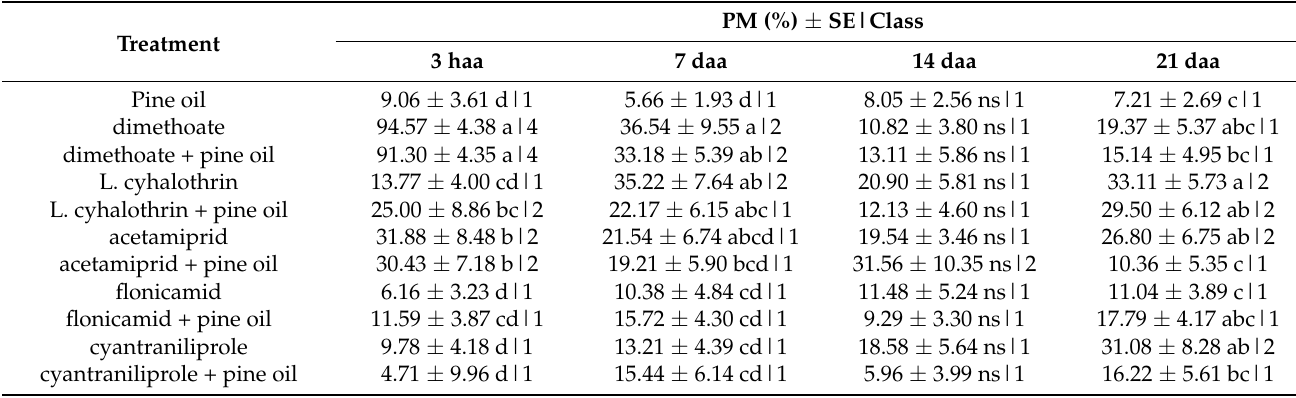
Table 5. Effect of insecticides and their combination with organic pine oil-based adjuvant on T. dryi adults under labora- tory